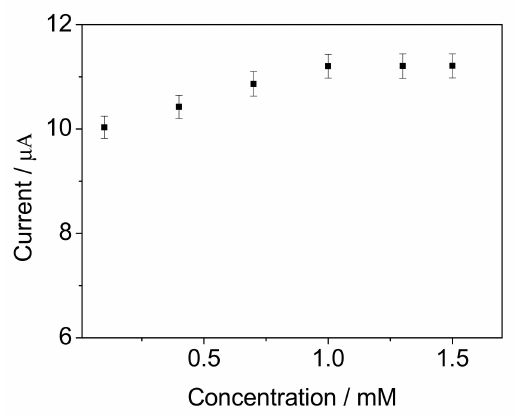
Figure 10. The influence of Py concentration on the current response for 50 mg/L BOD standard solution. The error bars represent three replicate measurements.